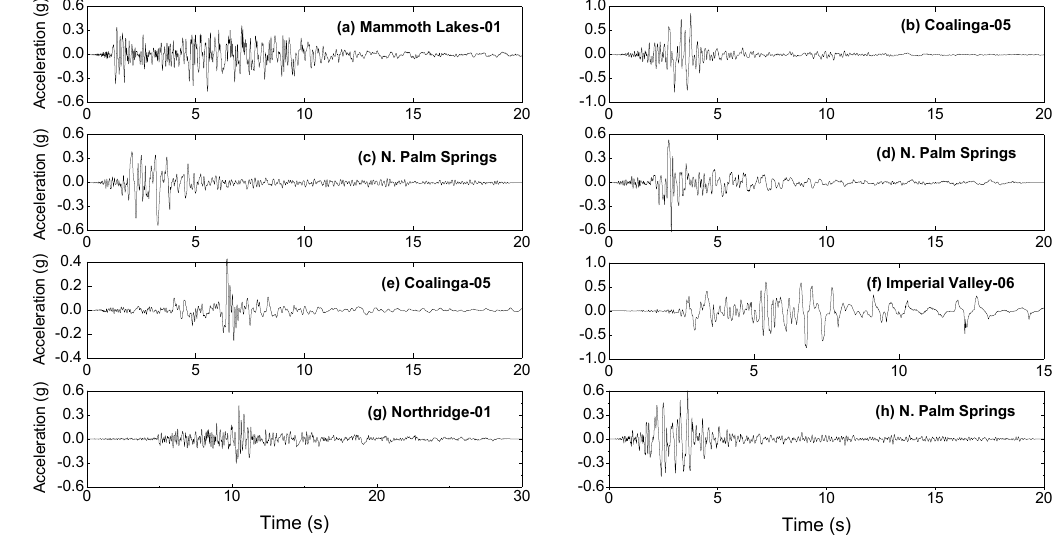
Figure 8. Eight time history recommendations for Taipei (site a) with DSHA calculations and the NGA strong-motion database.